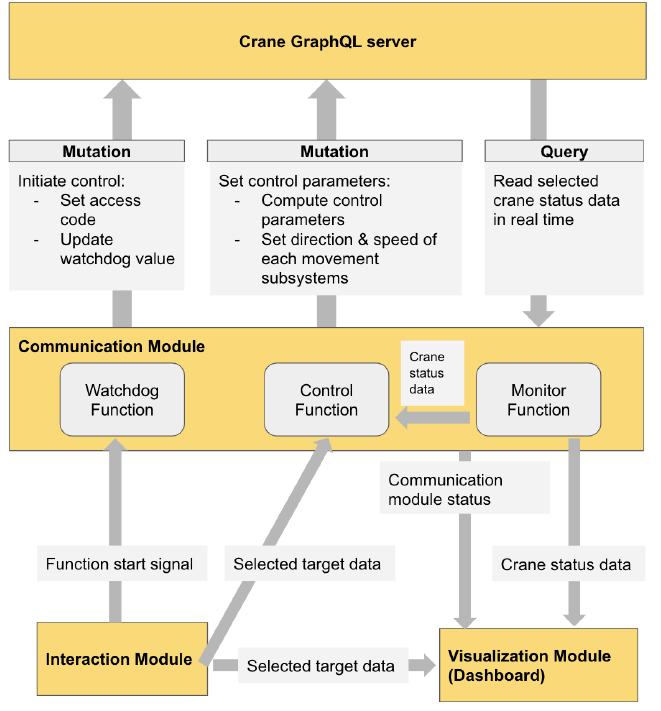
Figure 8. Functional components of the communication module and data flow: The interaction module set the execution of the watchdog function, which then sent mutation requests to the GraphQL server for setting the access code and updating the watchdog value constantly. On the other hand, the interaction module also provided the selected target data to the control function, which then computed the control parameter values and sent them as mutation requests. Meanwhile, the visualization module received constant updates of the crane status from the monitor function through its query requests from the server, the selected target data from the interaction module as well as the execution status of each function within the communication